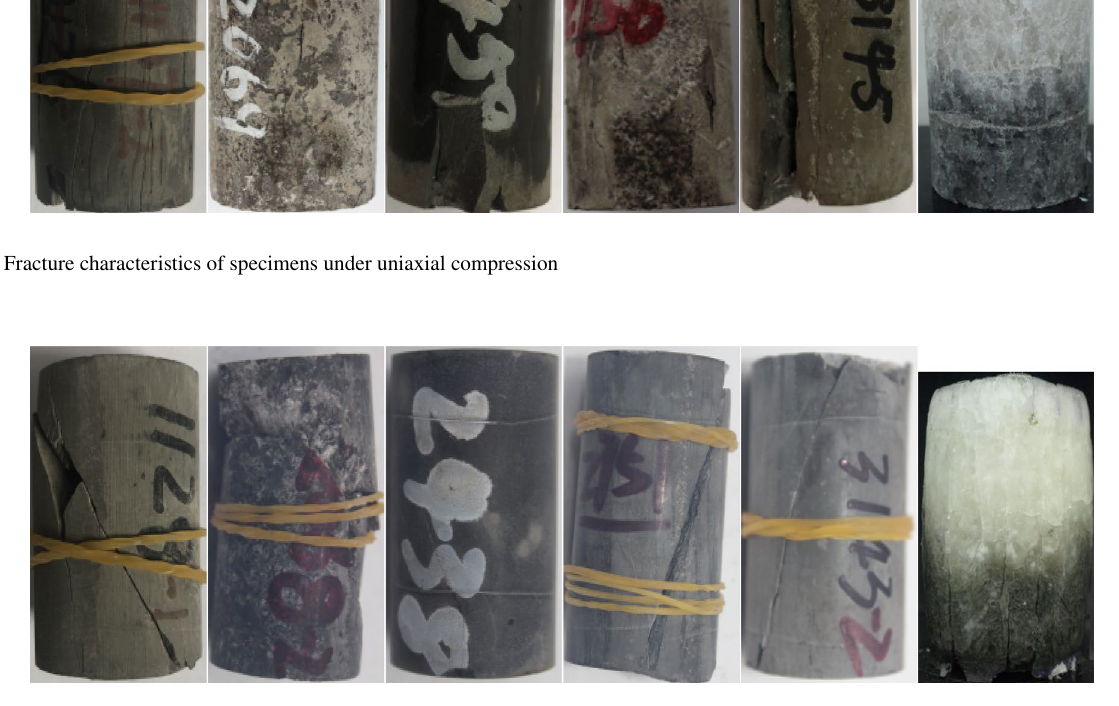
Fig. 5 Fracture characteristics of specimens under triaxial